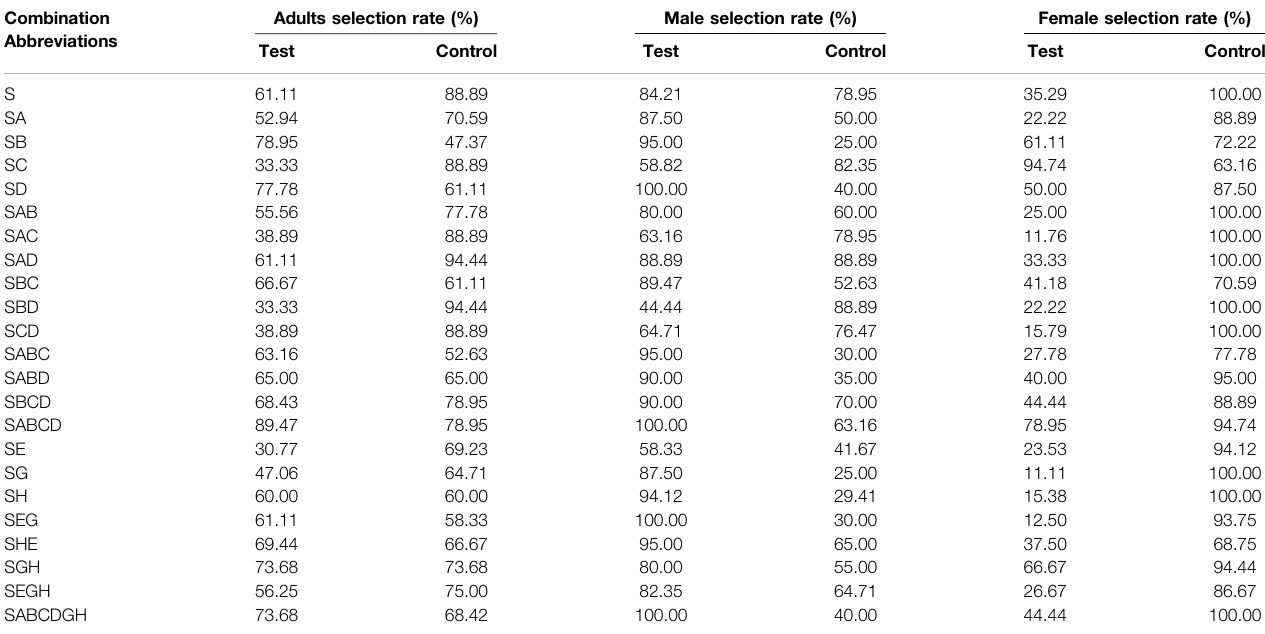
TABLE 2 | The selection rates of sexual attractant (S) plus different chemical substances, plant essential oils, and their combinations. Combination